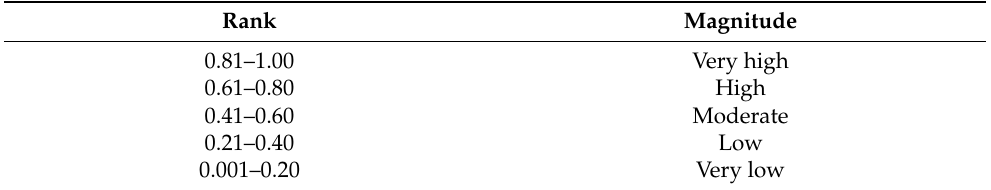
Table 3. The Cronbach alpha magnitude